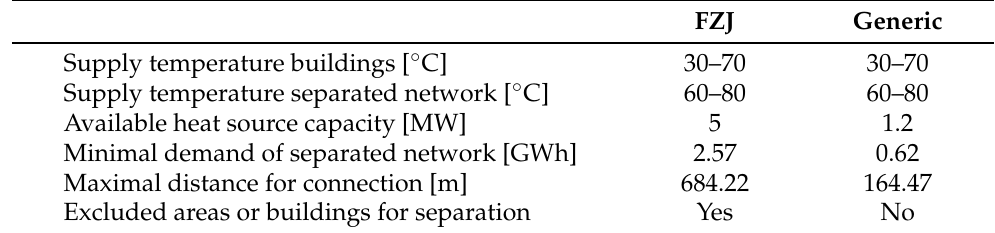
Table 1. Summarised characteristics of the investigated district heating systems and the utilised heat